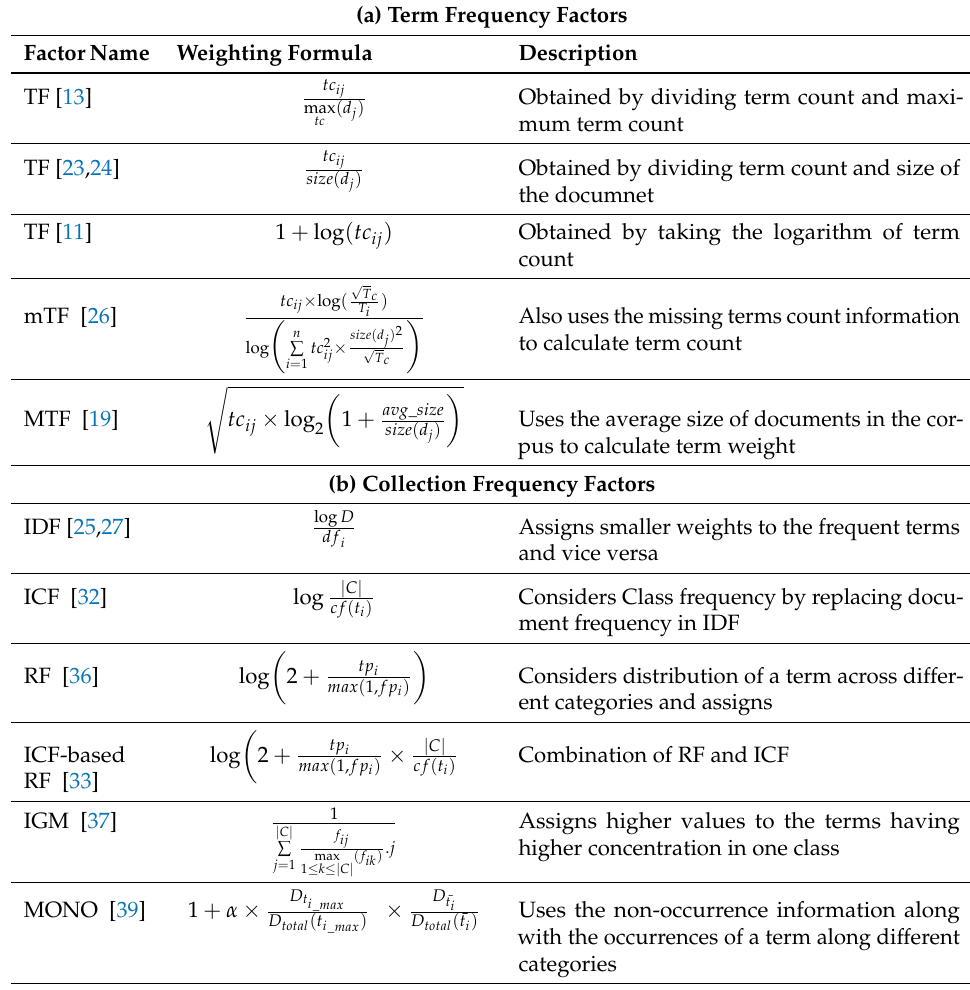
Table 1. Summary: Most commonly used term weighting schemes in